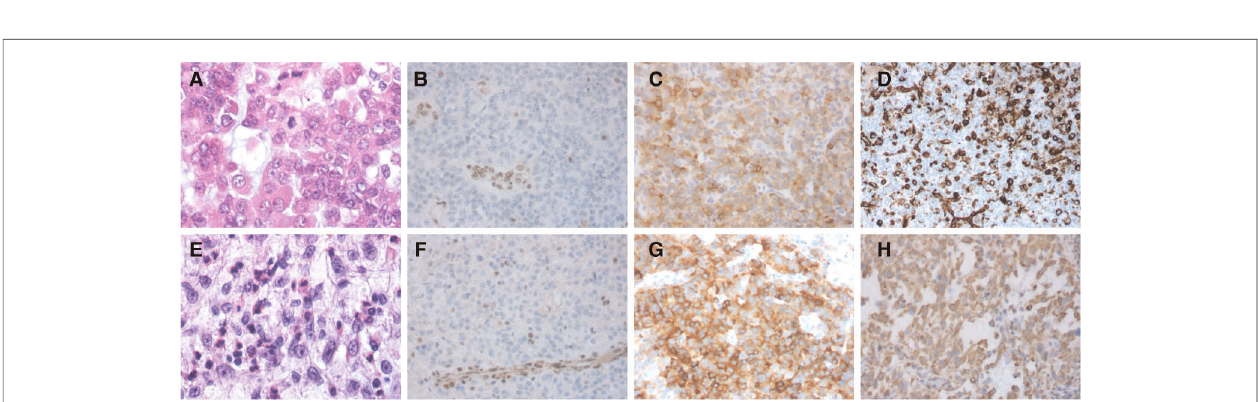
FIGURE 2 | Preoperative MRI: ( A ) axial T1 image; ( B ), axial T2 image; ( C ) coronal T1-weighted image with gadolinium contrast; ( D ) sagittal T1-weighted image with gadolinium contrast; ( E ) axial T1-weighted image with gadolinium contrast; Postoperative CT: ( F – H ) axial scan.